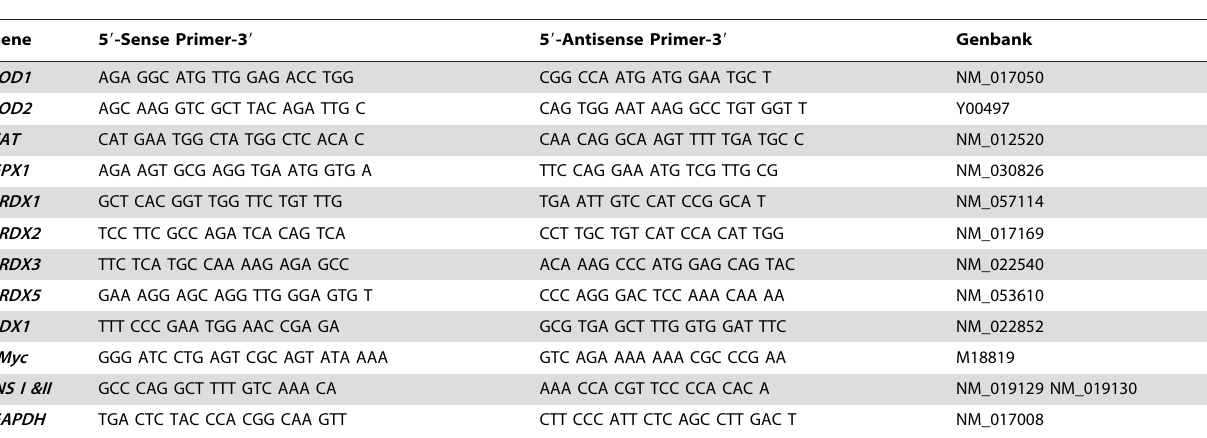
Table 3. Sequences of oligonucleotide primers and Genbank accession number.